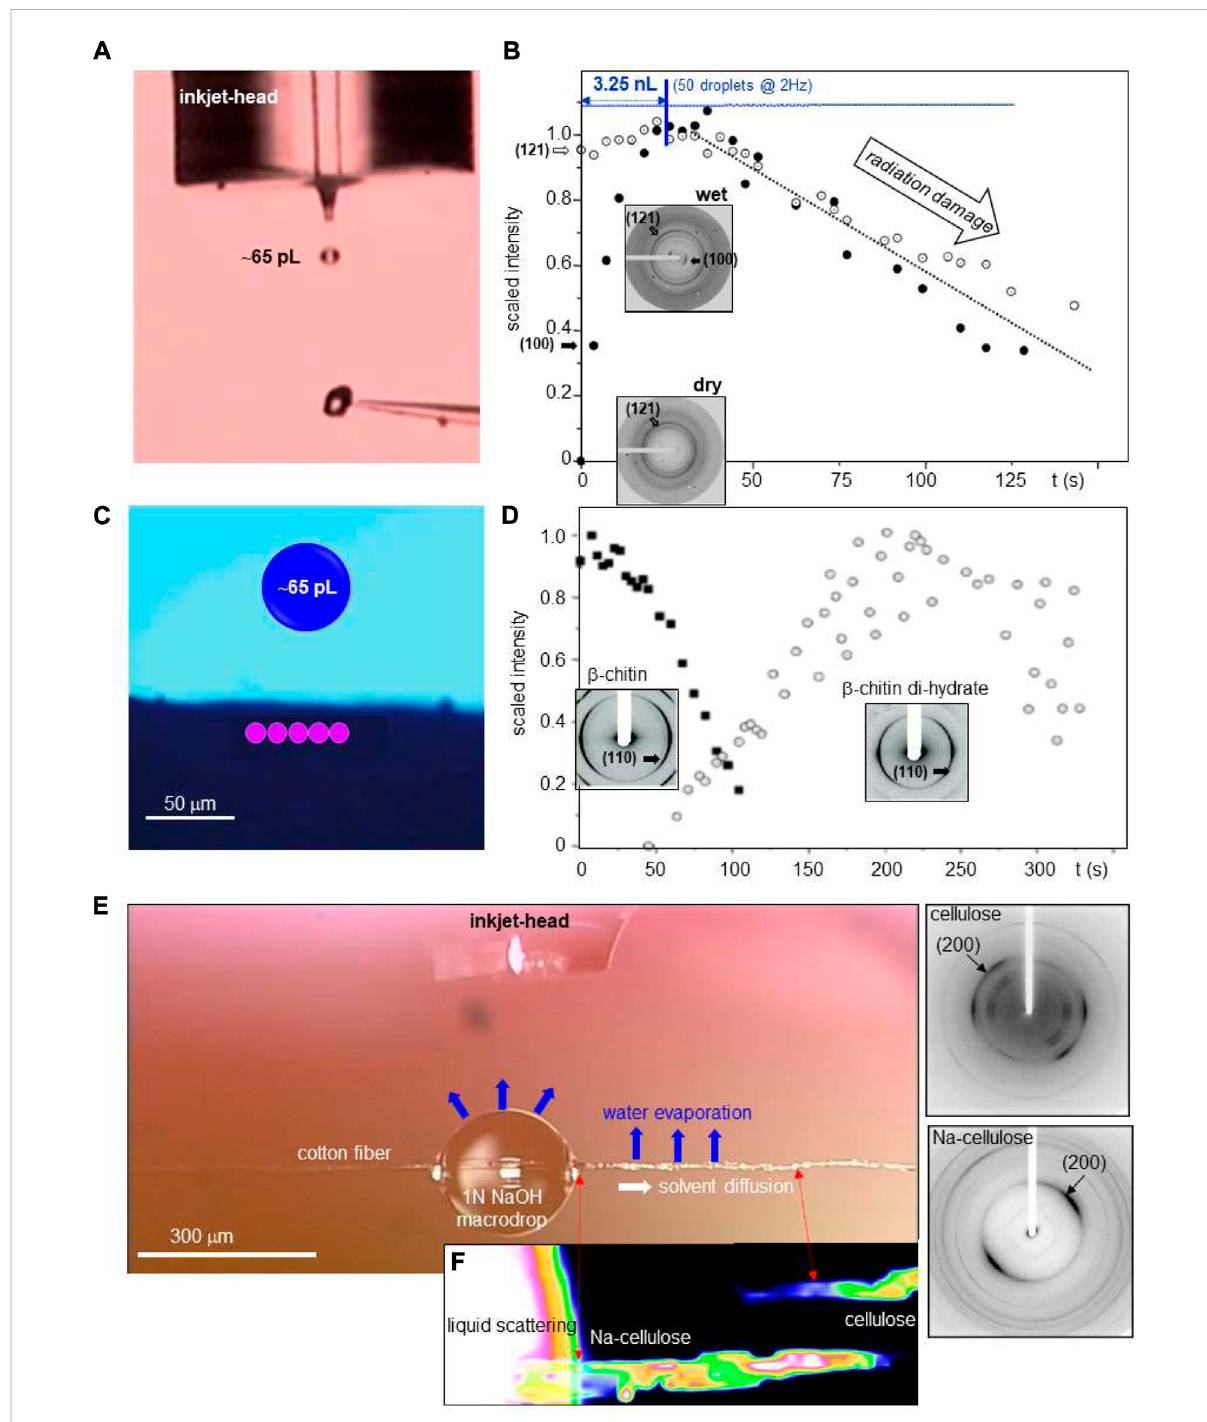
FIGURE 7 (A) Stroboscopic image of a ballistic water droplet directed towards a ~30 μ m diameter potato starch granule attached to a glass tip. (B) Structural kinetics of potato starch granule hydration based on 5 μ m focal spot. The variation of (100)/(121) Bragg peak intensities is shown during printingof~65 pLwaterdropletsat2 Hz.Insets:patternsofdryandhydrated starch.Thesequenceofwaterdropletsisshownschematicallyasaline of bluecircles. The maximum of crystalline hydrate isreached for overall ~3.25 nL water deposited. A/B: adapted from: (Lemke etal., 2004). (C) Schematic design of focal spot positions (in pink) on the sample and the size of a 520 pL droplet (in blue). (D) Structural kinetics of β -chitin hydration based on 10 μ m focal spot. The variation of β -chitin and β -chitin di-hydrate (110) Bragg peak intensities is shown. C/D: adapted from: (Roessle et al., 2003). (E) Inkjet head above cotton fi ber with deposited NaOH solution macrodrop. (F) Structural kinetics of Na-cellulose formation based on 300 nm focal spot. The heat map is based on (200) Bragg peak intensities of cellulose and Na-cellulose. The intensities are correlated with the volume concentration of both phases. Corresponding nanoXRD patterns are shown to the right. Adapted from: (Schoeck et al.,